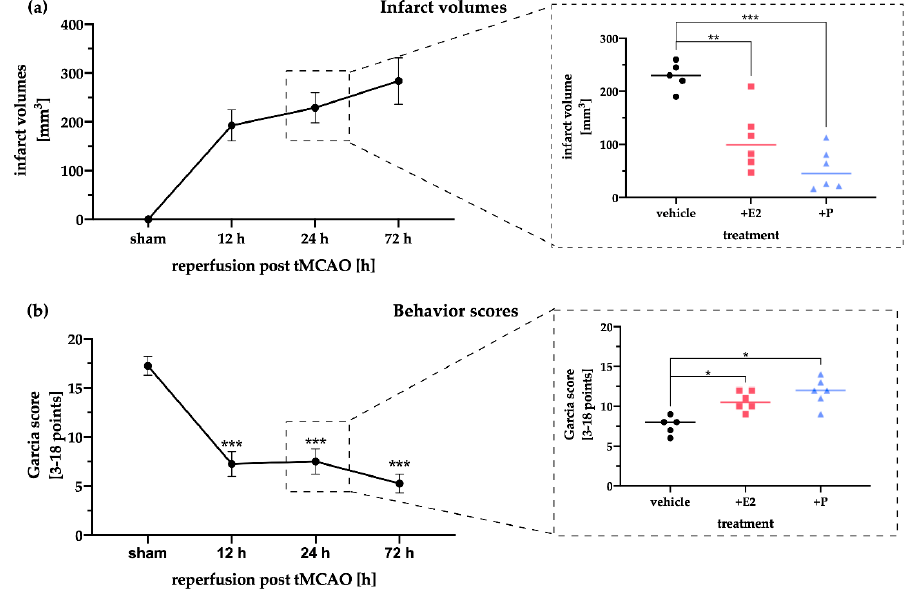
Figure 1. Determination of the infarct volume and the Garcia behavioral score after tMCAO. ( a ) The infarct volume increased over time with prolonged reperfusion and peaked at 72 h. Steroid hormone therapy with E2 or P significantly reduced the infarct volume at 24 h of reperfusion post tMCAO. Note that one animal in the E2 group exhibited a larger infarct volume compared to the other rats in the same group, but this value was not significant in the outlier test (Grub and Rout tests). ( b ) The behavior score dropped during reperfusion to a minimum at 72 h of reperfusion. After E2 and P therapy, higher Garcia scores were determined for both treatments. Note that a minimum score of 3, indicating maximum pathology, and a maximum of 18, no signs of any deficit, were possible. p -values: * ≤ 0.05; ** ≤ 0.01; *** ≤ 0.001, asterisks indicate sham vs time points (left panels) or vehicle vs E2 / P treatment (right panels). Data represent the means ± SEM. n = 5 (sham) or n = 6 (E2 / P). tMCAO–transient Middle Cerebral Artery